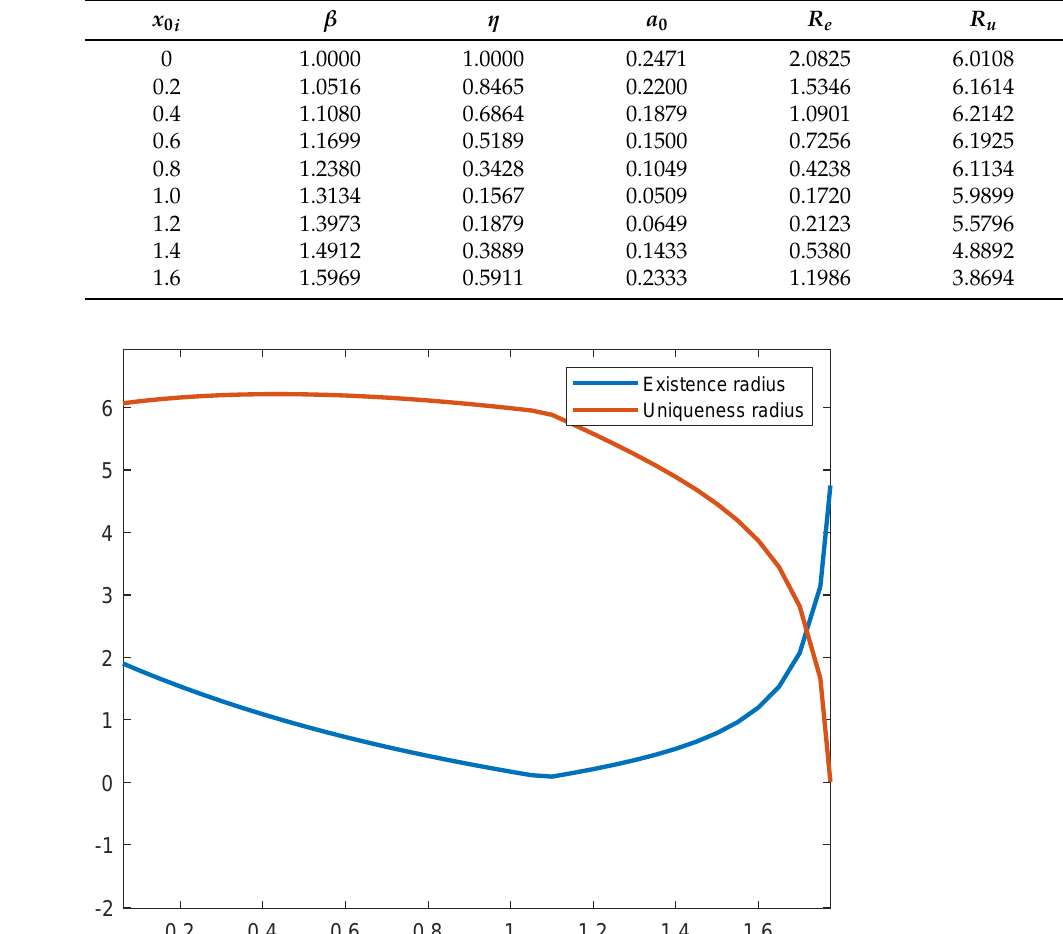
Figure 1. Radii of existence and uniqueness for different initial estimations. The approximated solution of the system (16) after 5 iterations of multidimensional Chun’s method taking x 0 = ( 1.7, 1.7, . . . , 1.7 ) T and as stopping criterium (cid:107) x n − x n − 1 (cid:107) ∞ < 10 − 180 or (cid:107) F ( x n ) (cid:107) ∞ < 10 − 180 , can be seen in Table 2. The software used is MATLAB 2019b